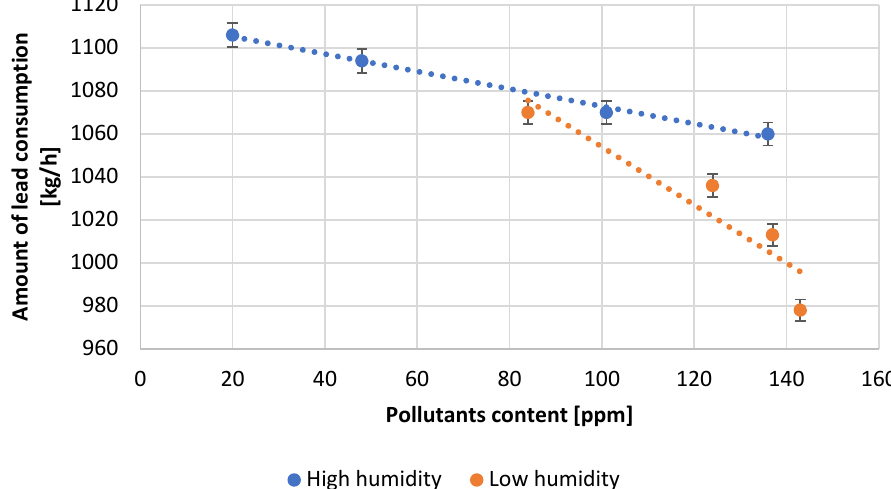
Figure 5. Dependence of amount of lead used on pollutants content.